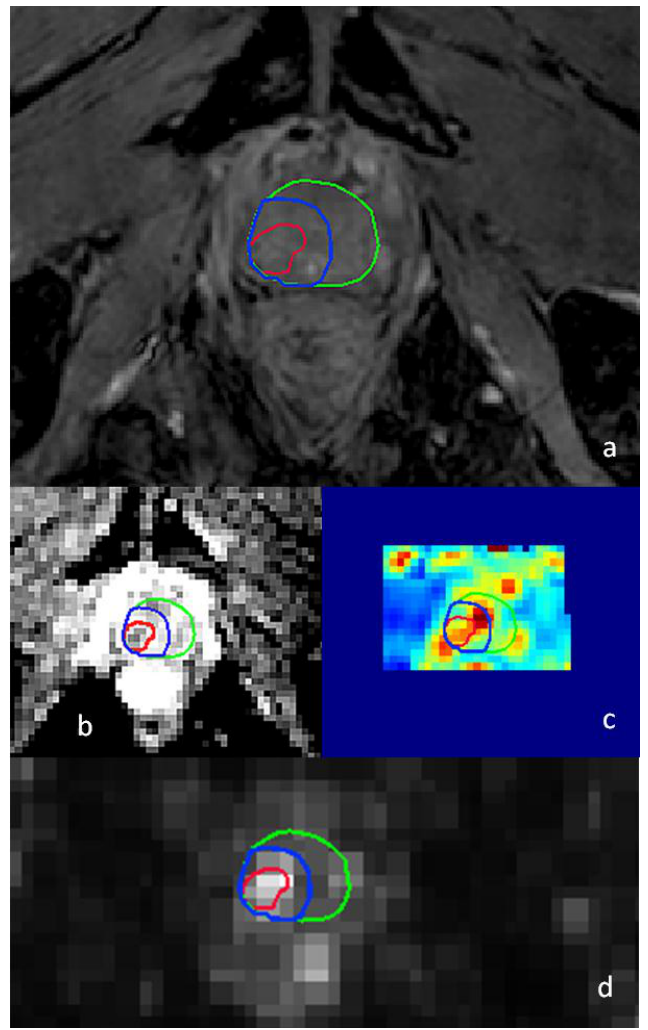
Figure 1. Recurrent prostate cancer lesion on diagnostic 3-T multiparametric magnetic resonance imaging (mp-MRI) ( a – c ) and prostate-specific membrane antigen positron-emission computed tomography (PSMA-PET/CT) ( d ). The suspect lesion is visible in the right peripheral zone of the apex. Delineations of the prostate (green), gross tumor volume (GTV, red), and clinical target volume (CTV, blue) are displayed. ( a ) T2-weighted MRI; ( b ) apparent diffusion coefficient (ADC) map of diffusion-weighted imaging (DWI)-MRI; ( c ) K-trans map of dynamic contrast-enhanced (DCE)-MRI; ( d ) 68 Ga-PSMA-PET/CT.